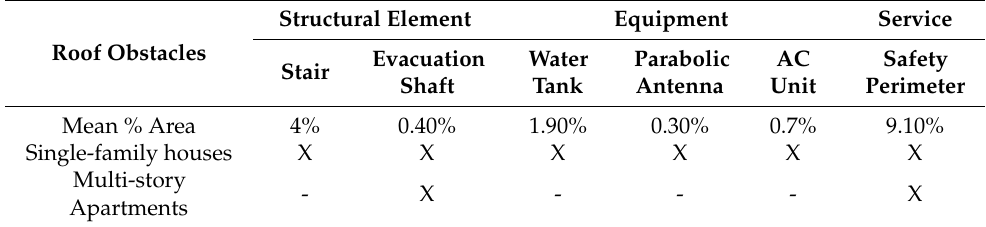
Table 1. The obstacles identified on a residential roof.